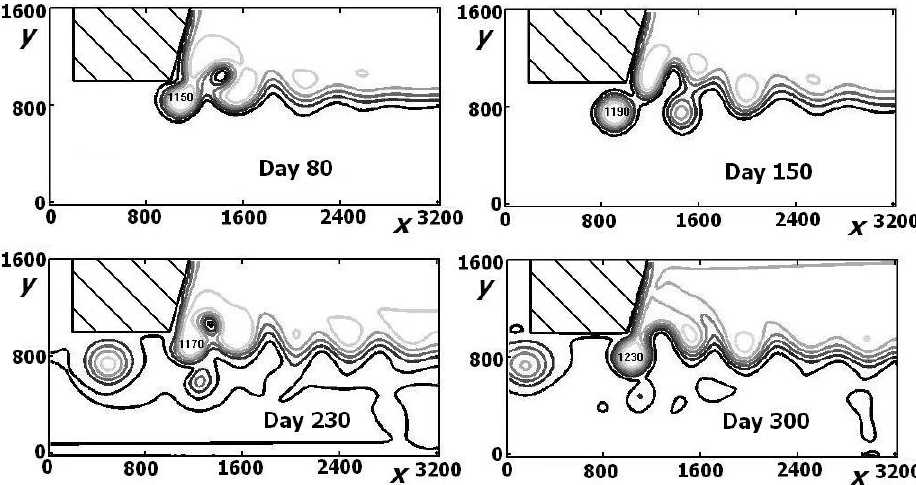
Fig. 7. Upper layer thicknesses for the case of a Concave I coastline with a sharp kink (large γ ) and a current with modest vorticity ( γ = 75 ◦ , α = 0 . 4, h 0 = 300m, ν = 700m 2 s − 1 , and β = 6 × 10 − 11 m − 1 s − 1 ). Here, the eastern wall slant is too high to allow for ring production, so rings are produced just downstream of the kink, which effectively locks the position of the retroflection. Only one eddy is detached; a second one is about to be detached on day